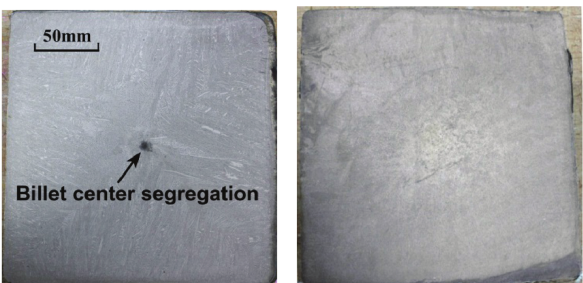
Figure 11: Comparison of macrostructure of billet cross section before and after